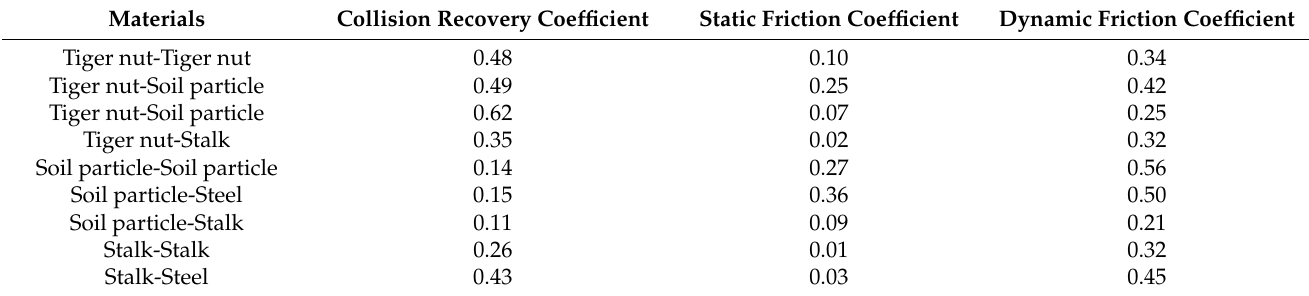
Table 4. Parameters of contact coefficients.